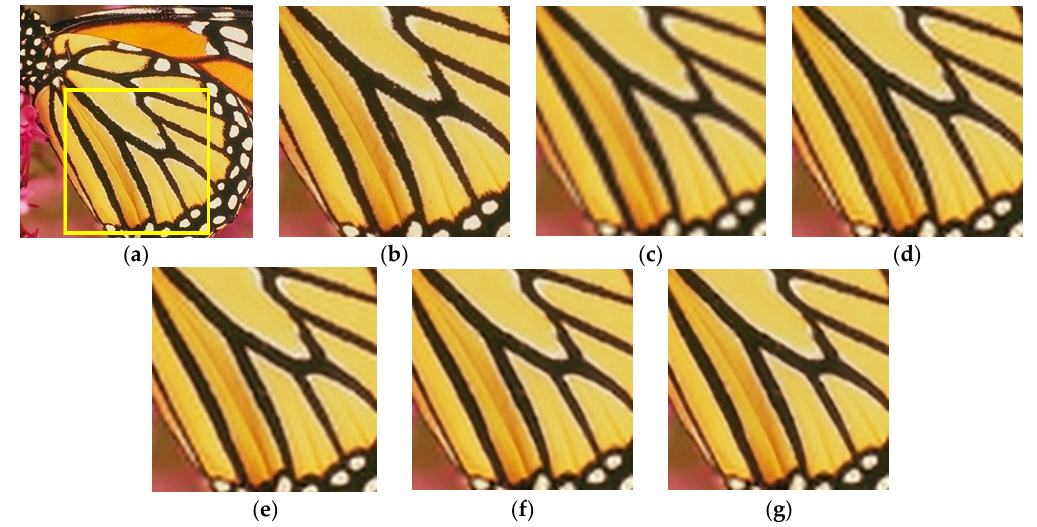
Figure 5. Reconstructed results of Butterfly using the dictionaries with different numbers of hidden units. ( a ) Butterfly; ( b ) Reference; ( c ) Bicubic; ( d ) Hidden units 256; ( e ) Hidden units 512; ( f ) Hidden units 1024; ( g ) Hidden units 2048. Table 1. Comparison of the peak signal-to-noise ratio PSNR (dB) and the structural similarity measure (SSIM) of the reconstructed images using the dictionaries with different numbers of hidden units for Set5 (PSNR/SSIM).